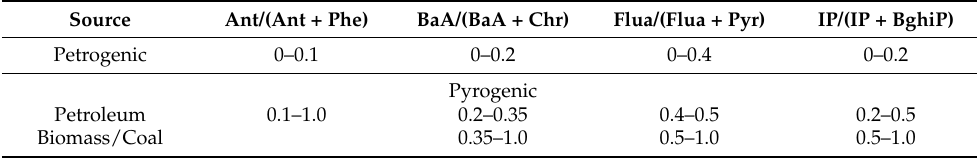
Table 1. PAHs molecular diagnostic ratios (MDRs) [50,52,53].